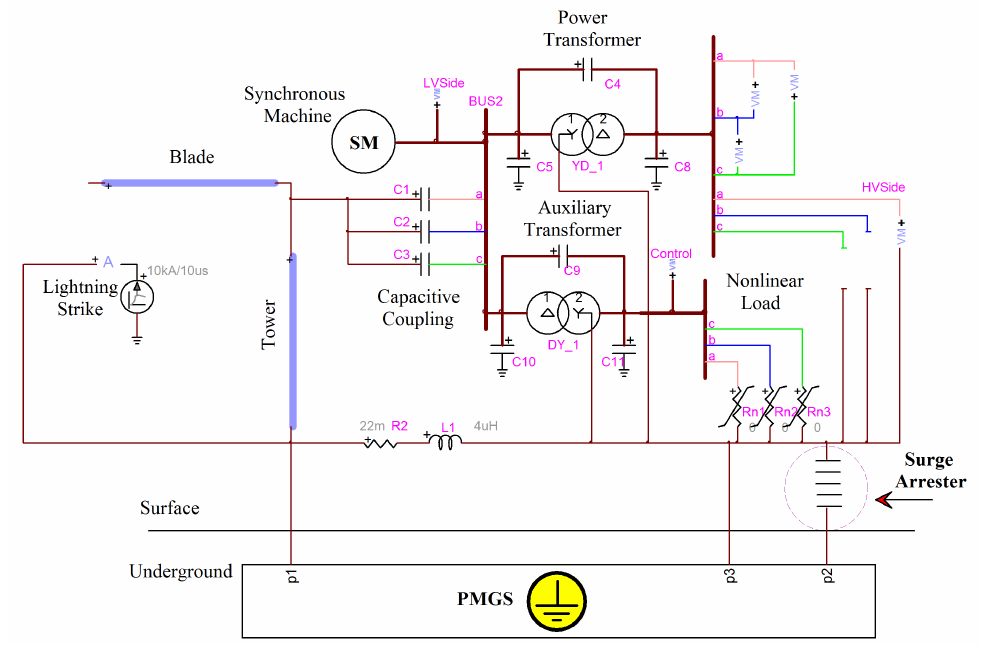
Figure 5. Circuit of the simulated wind turbine with a surge